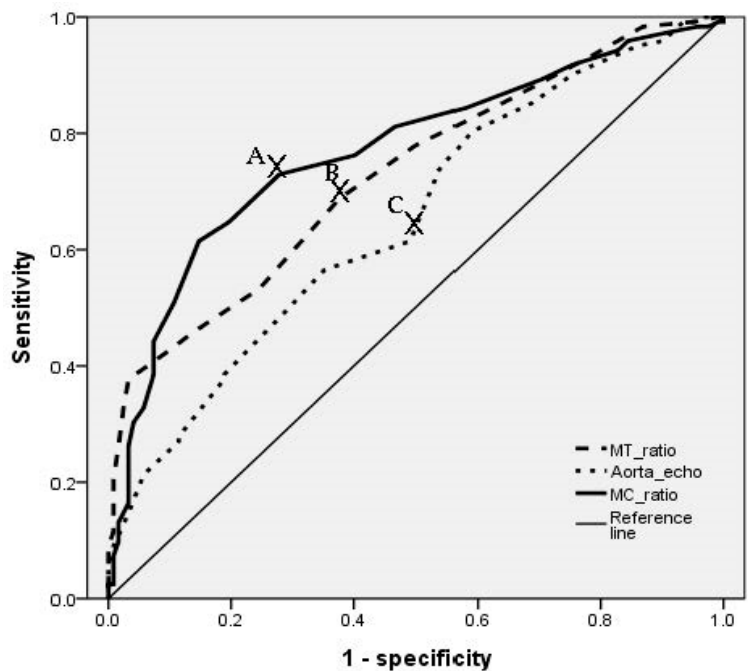
Figure 4. Receiver operating characteristics (ROC) curve of radiologic and echocardiographic pa- rameters for prediction of catheter selection. ( A ) Cut off value of mediastinal-cardiac ratio on chest X-ray–0.47. (SN: 0.689, SP: 0.562, OR: 5.61, AUC: 0.769, 95% CI: 0.708~0.829). ( B ) Cut off value of mediastinal-thoracic ratio on chest X-ray–0.23. (SN: 0.734, SP: 0.566, OR: 1.91, AUC: 0.730, 95% CI: